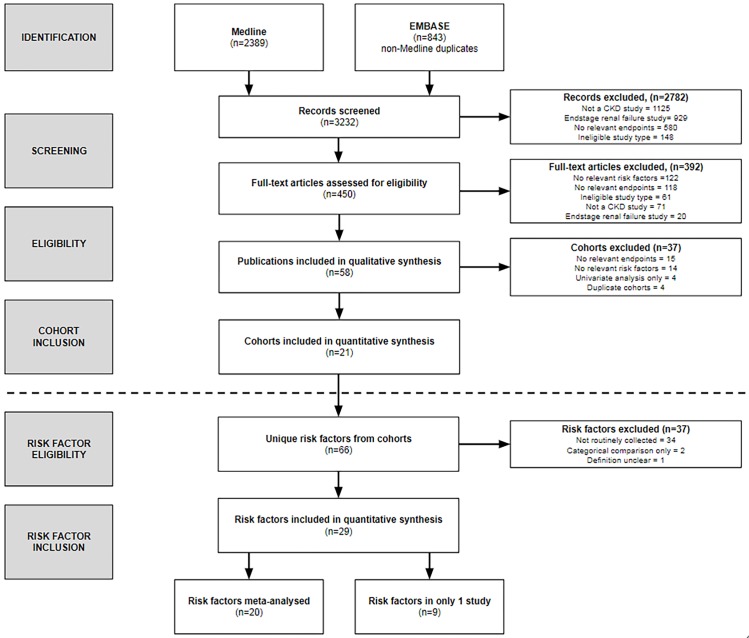
Flowchart showing the number of cohorts and risk factors identified, screened and included in the systematic review.